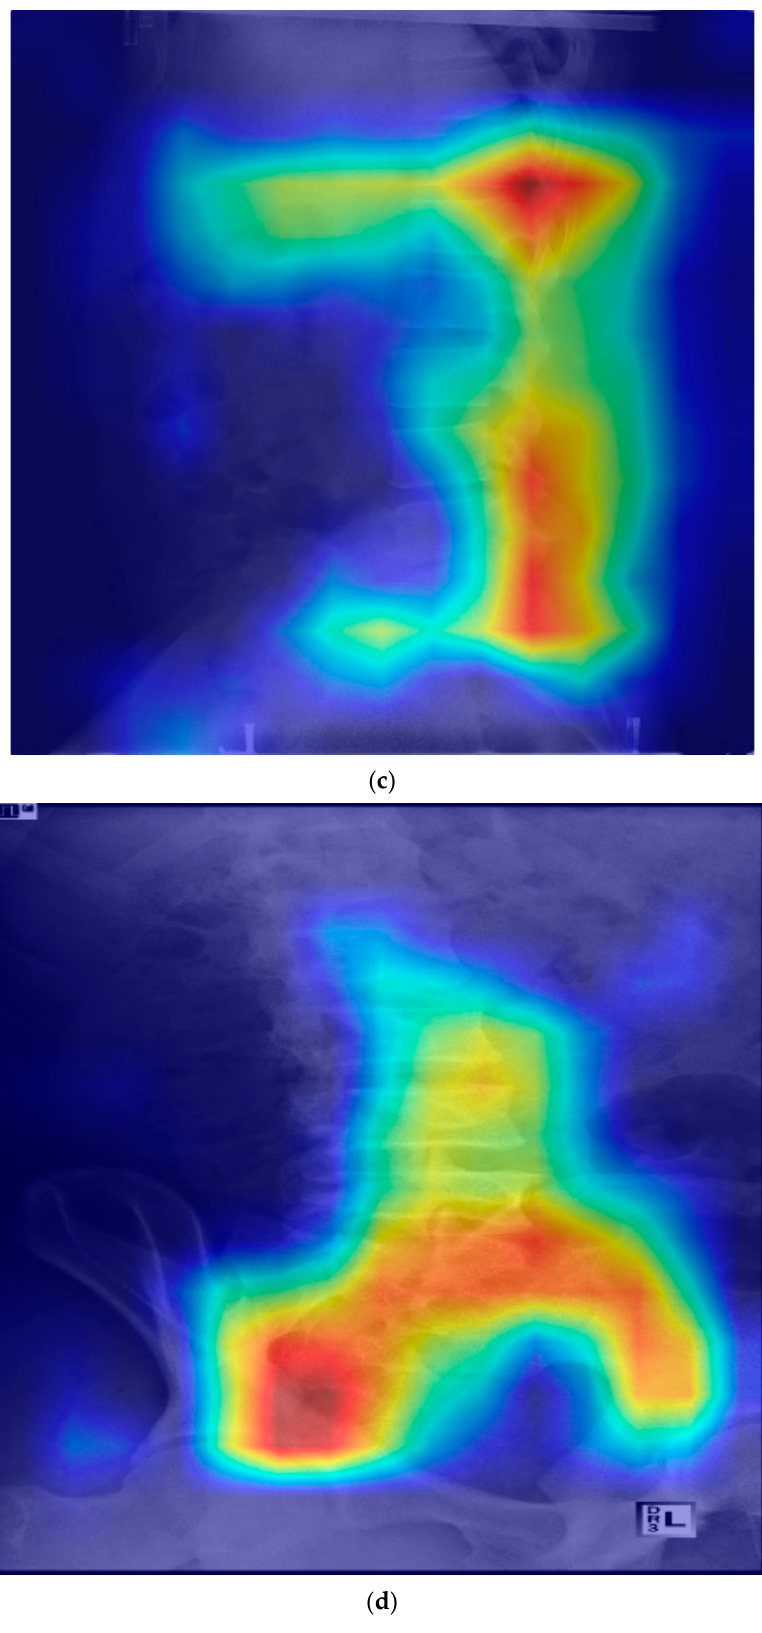
Figure 1. Gradient-weighted class activation mapping for the prediction model of lumbar HNP. HNP, herniated nucleus pulposus; L, lumbar; S, sacrum. ( a ) Heatmap in lateral view of the disk and vertebrae area (HNP in L4-5 and L5-S1). ( b ) Heatmap in anteroposterior view of the disk and